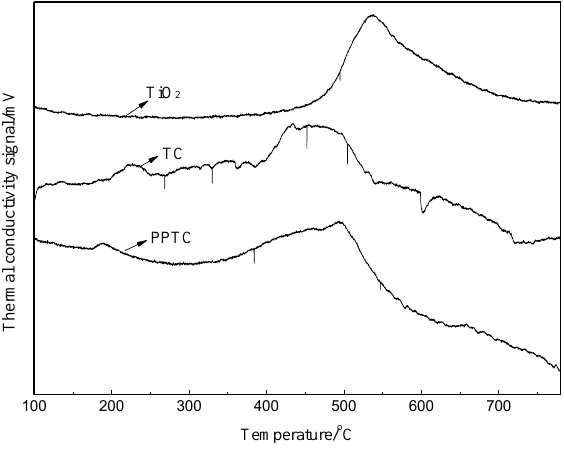
Figure 10. H 2 -temperature-programmed reduction (TPR) curves of TiO 2 , TC, and PPTC.